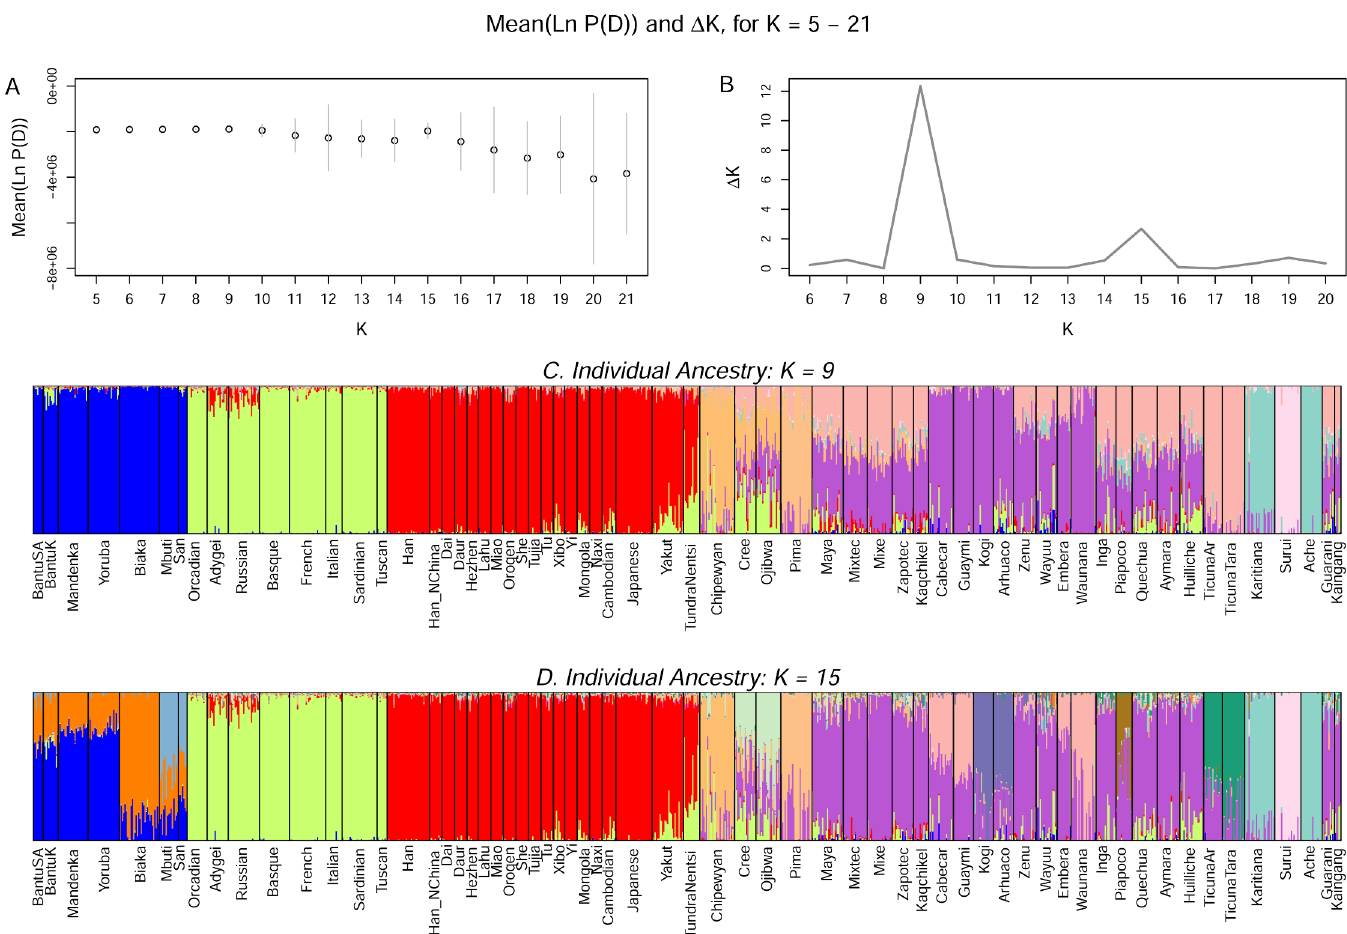
Fig 1. A. Mean log probability of data +/- 1 SD for K = 5 – 15. B. Δ K . C. Bar chart of individual ancestry for a typical run at K = 9. D. Bar chart of individual ancestry for a typical run at K = 15.